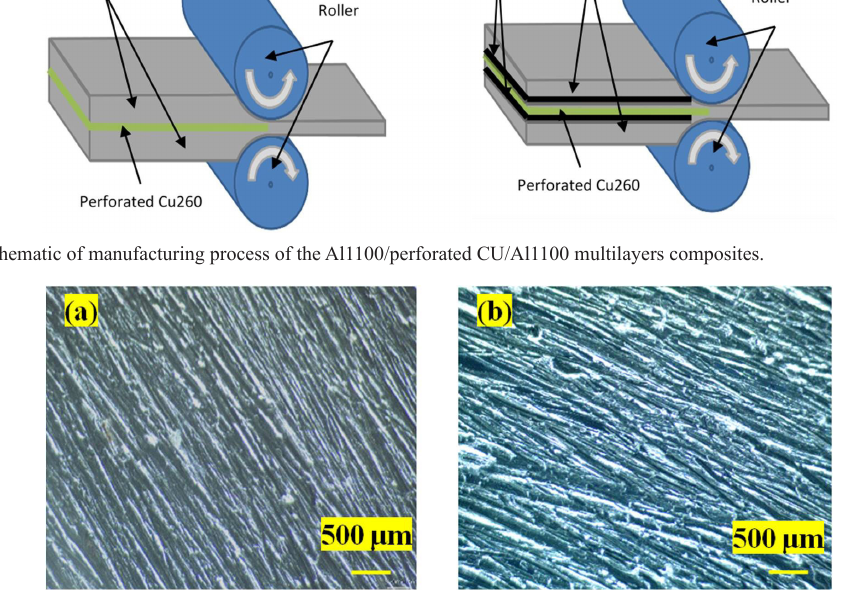
Figure 2. Optical microscopic images of the Al1100 roughened with different sandpapers grit sizes: (a) Grit-80 (Ra=3.75 µm), (b) Grit- 50 (Ra=5.63 µm).